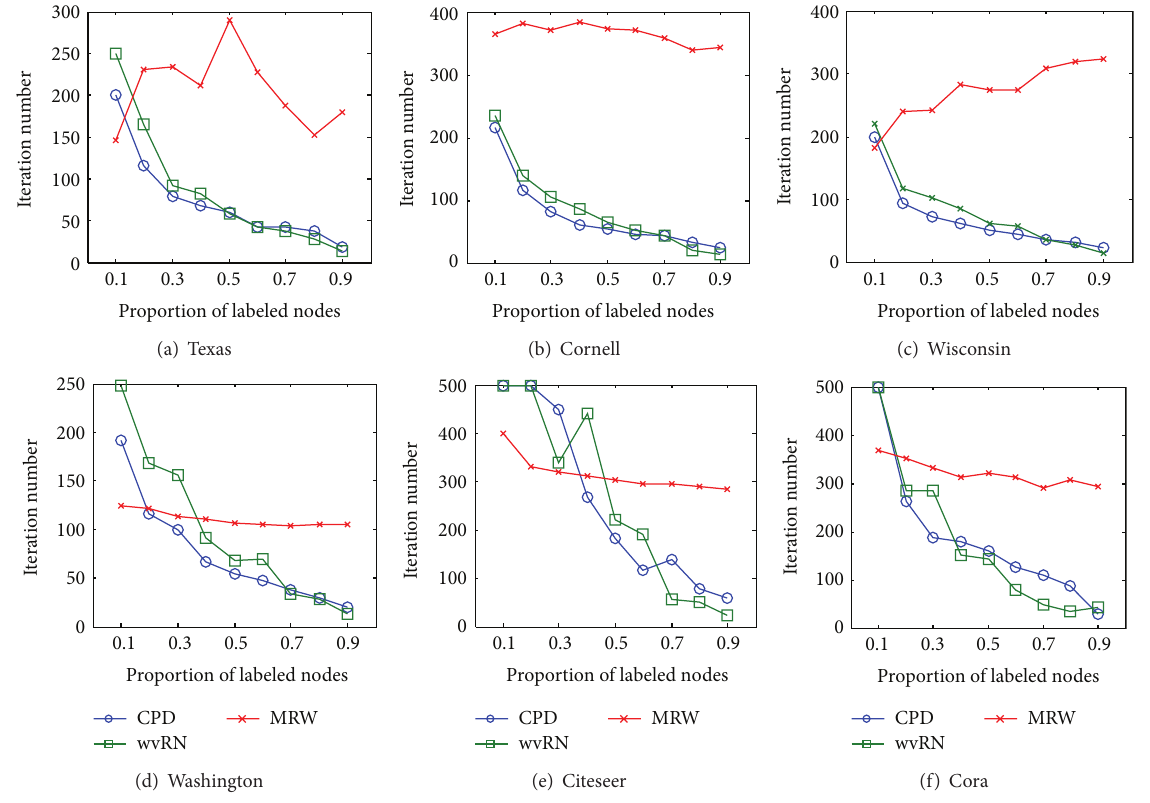
Figure 2: The comparison of iteration